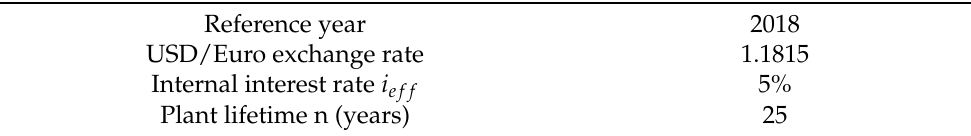
Table 5. General techno-economic